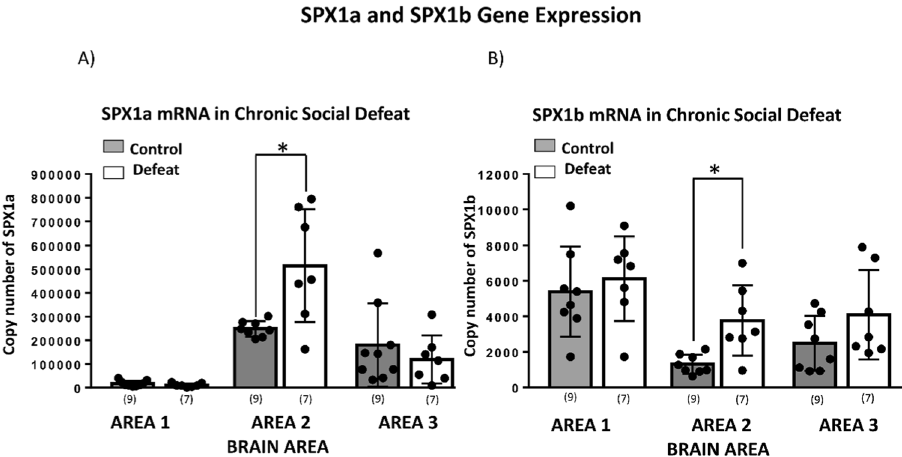
Figure 4. SPX1a and SPX1b gene expression in chronic social defeat. ( A ) SPX1a was upregulated in area 2 after chronic social defeat. ( B ) SPX1b was also upregulated in area 2 after chronic social defeat. All data are expressed as the mean ± SEM per group, and independent sample T-test was carried out using SPSS. Statistical significance was defined as P value less than 0.05. ( * p <